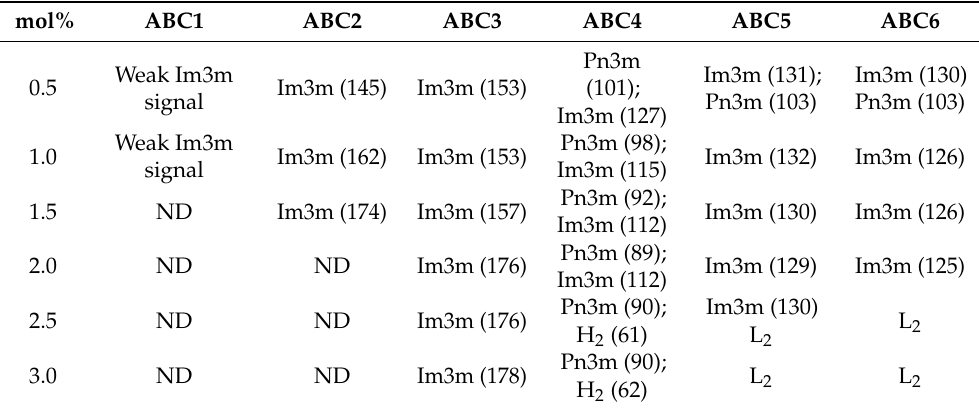
Table 1. Mesophase identification and calculated lattice parameters (Å) of the MO nanoparticles stabilized by the synthetic